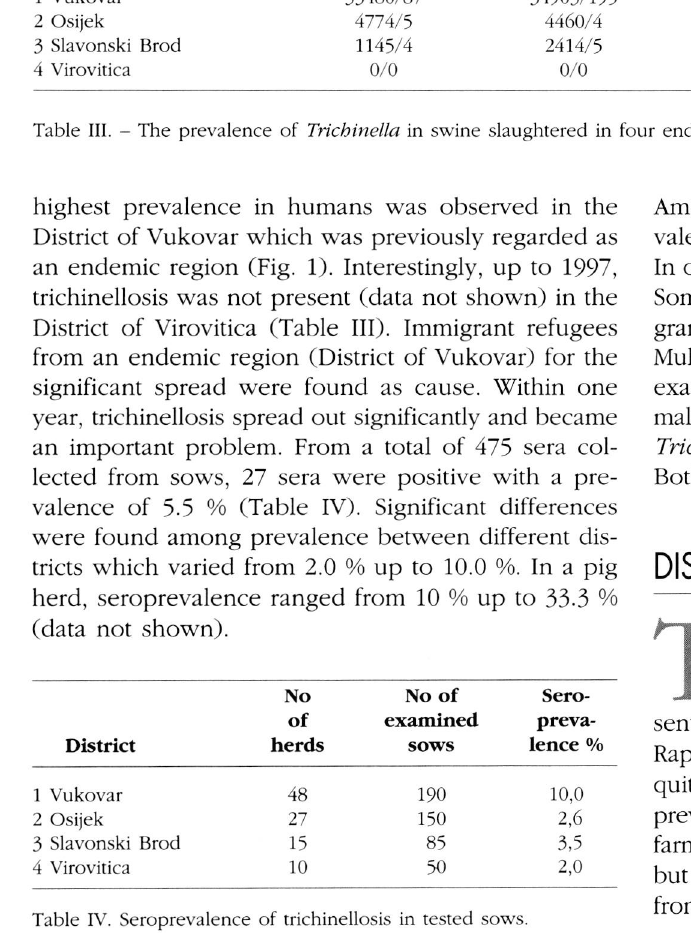
Table II. - The prevalence of Trichinella in rats trapped in small pig farms with high prevalence. Fig. 1. - Endemic trichinellosis districts.